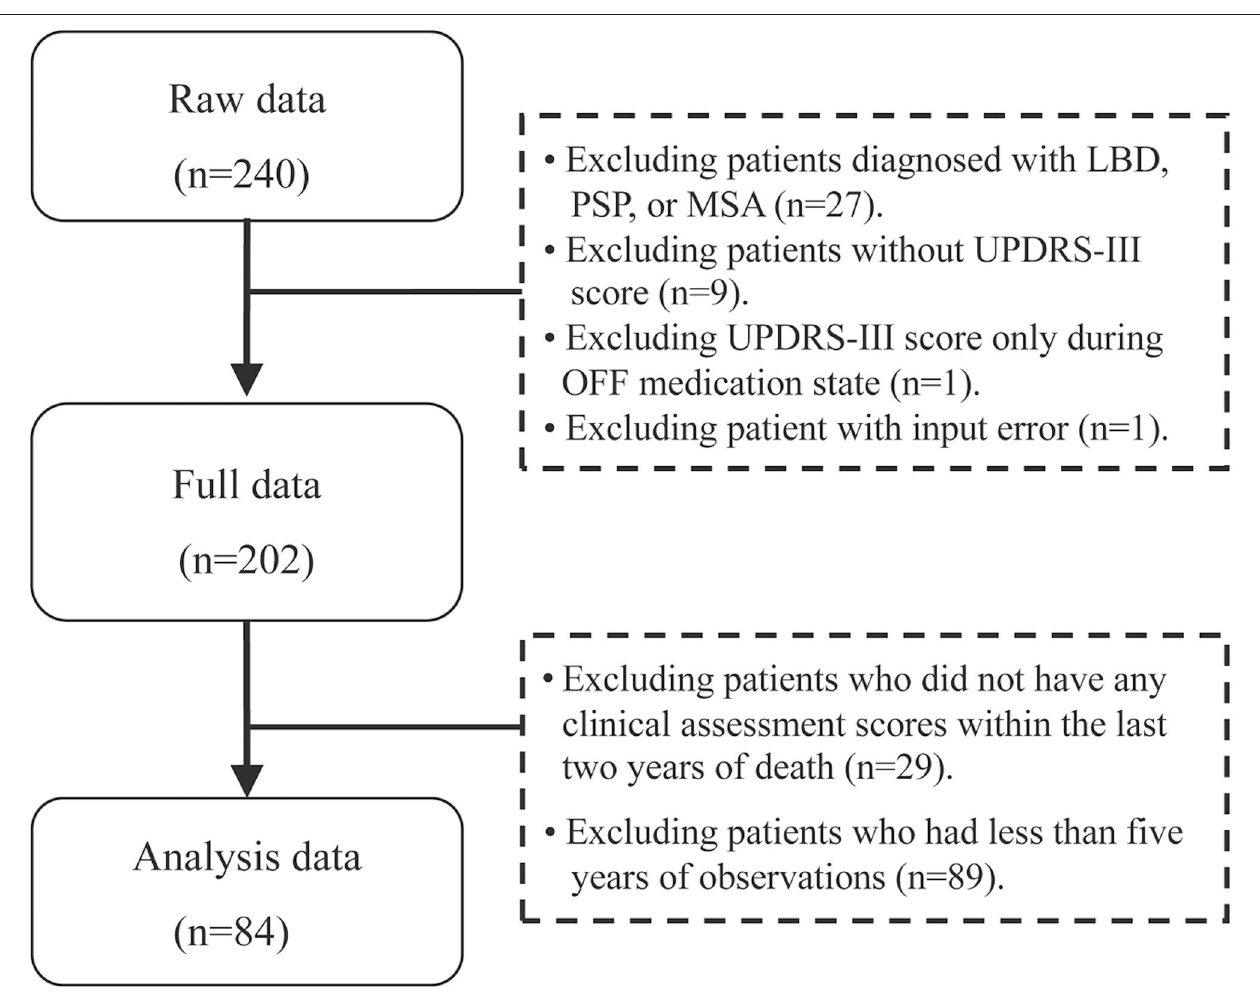
FIGURE 1 | Flowchart of data collection of the patients with Parkinson’s disease. Flowchart of final sample of the Parkinson’s patients: 84 patients meeting inclusion criteria were analyzed as shown in the flowchart. PD, Parkinson’s disease; LBD, Lewy body dementia; MSA, multiple system atrophy; PSP, progressive supranuclear palsy; UPDRS-III, Unified Parkinson’s Disease Rating Scale motor